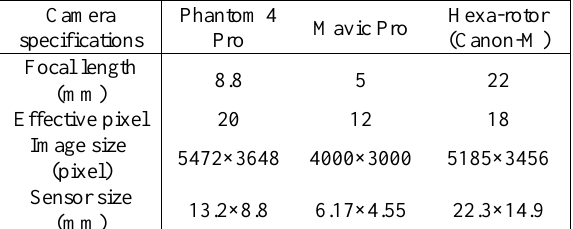
Table 1. UAVs camera specifications.